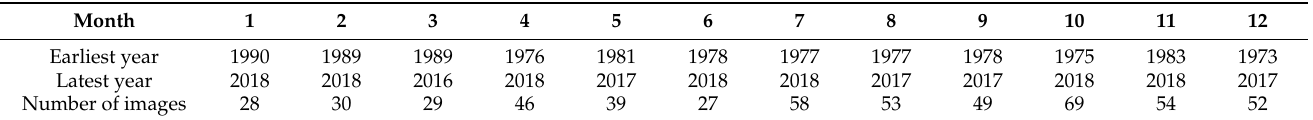
Table 1. Monthly available data.